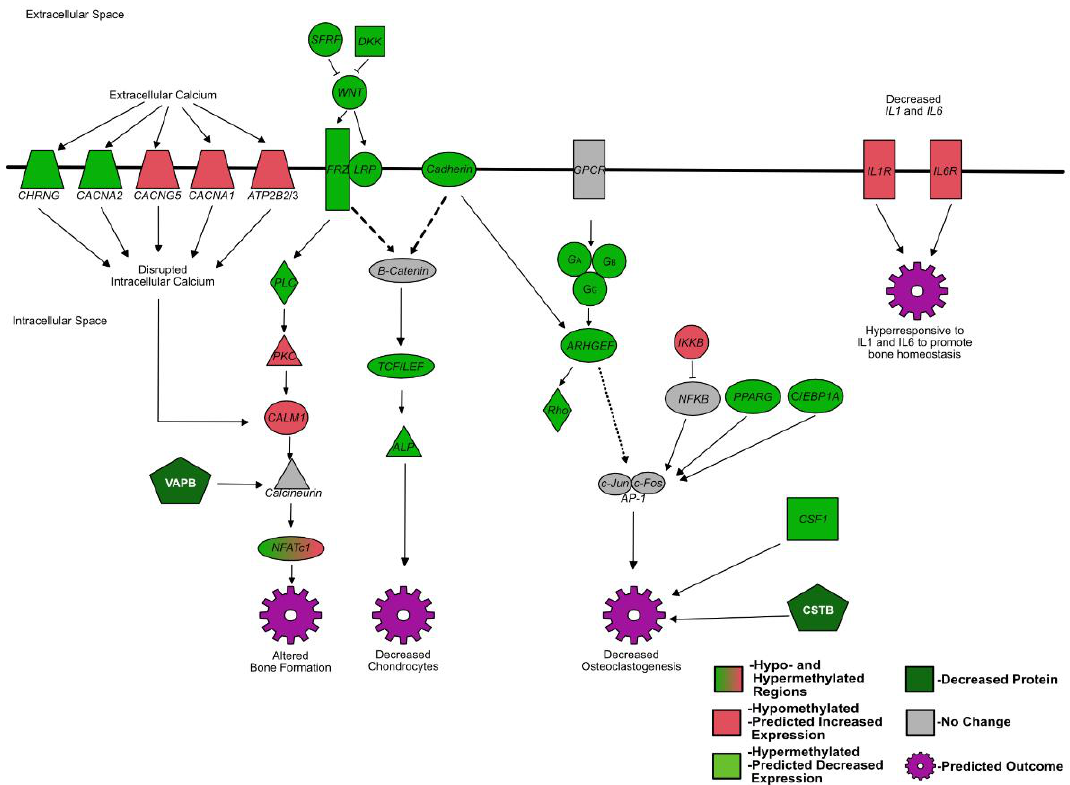
Figure 2. Summarized differentially methylated pathways in PI fetal spleens associated with bone development and osteoclast differentiation. Green = hypermethylated, predicted decreased expres- sion; red = hypomethylated, predicted increased expression; gray = not differentially methylated or not identified in RRBS; white text: protein.